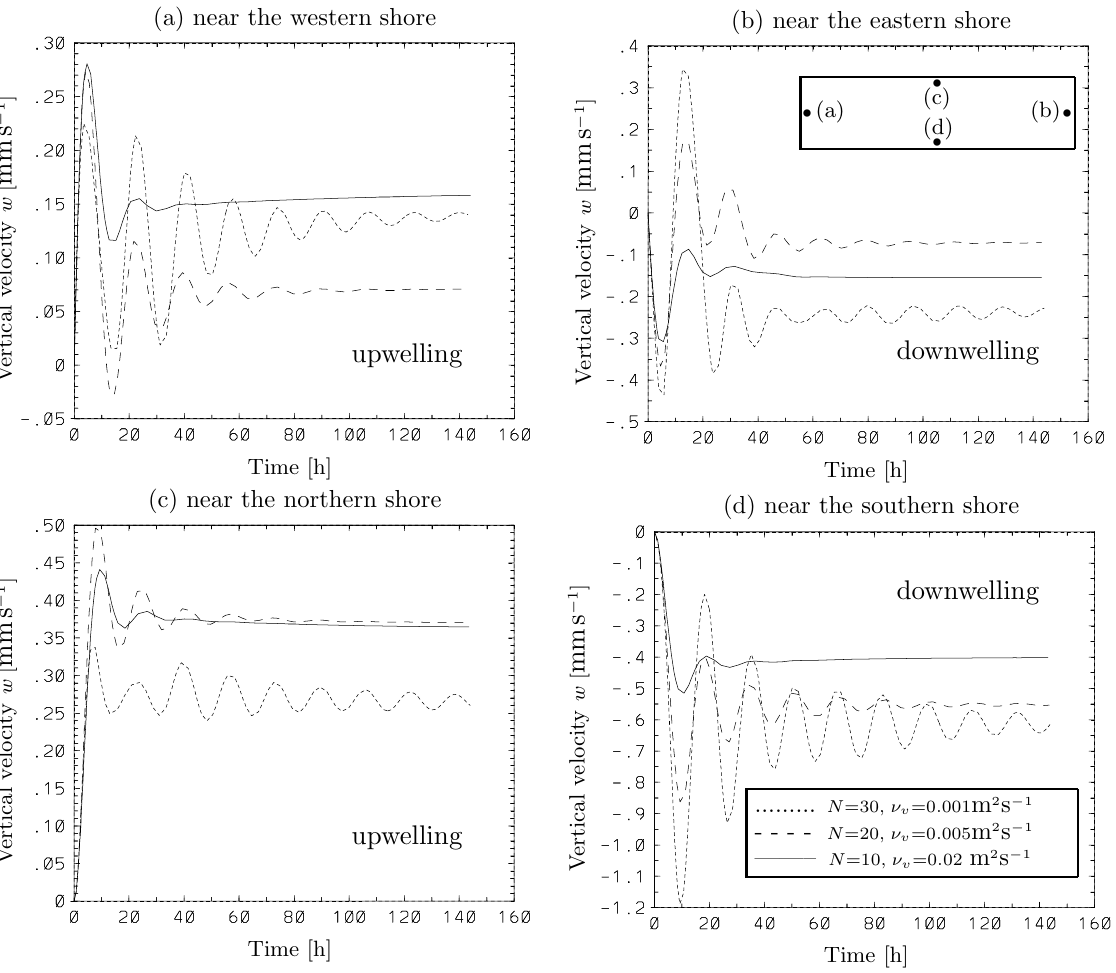
FIG. 1: Rotation angle Φ between wind and surface current (a) and absolute fluid velocity V free surface (b). Here Φ and V surf are plotted against ν v (solid curves), A (broken curves), A 0 (dotted curves), respectively, corresponding to the cases (i), (ii) and (iii)